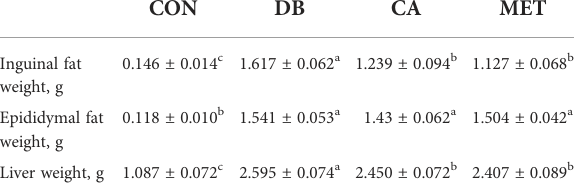
TABLE 2 Effects of chlorogenic acid on adipose tissue and liver weight in db/db mice. CON DB CA